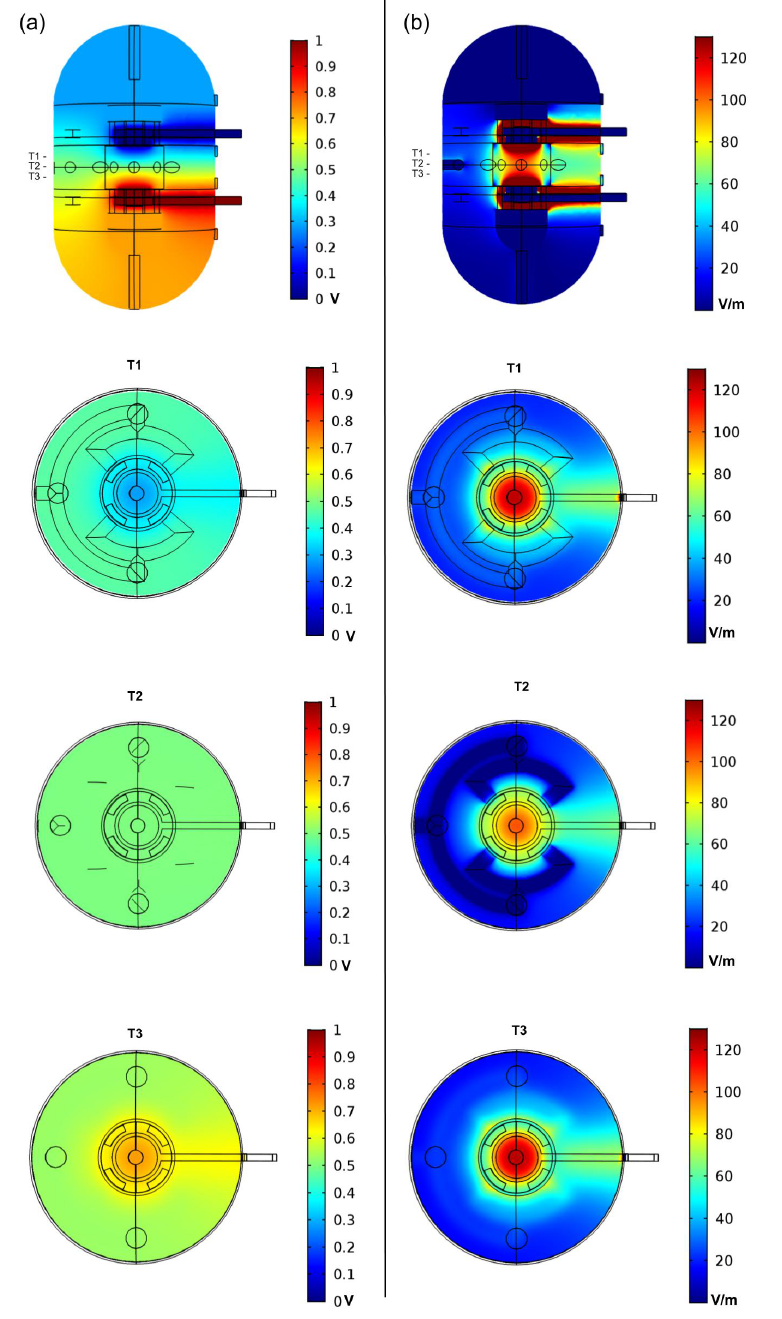
Figure 4. Numerical finite element analysis (FEA) analysis of the proposed bioreactor design with a DC electric stimulation parallel plate capacitor set-up with lateral and top slice views. The three top views represent the ROI upper slice (T1), the ROI middle plane slice (T2) and the ROI bottom slice (T3). ( a ) Electric potential distribution predicted in the bioreactor due to DC stimulation. ( b ) E-Field magnitude distribution predicted for the same electric DC stimulation